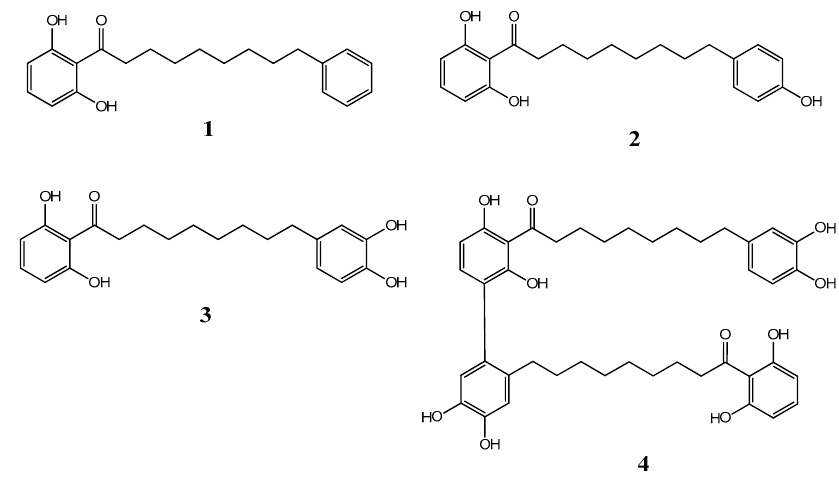
Figure 1. Structures of compounds 1 – 4 .